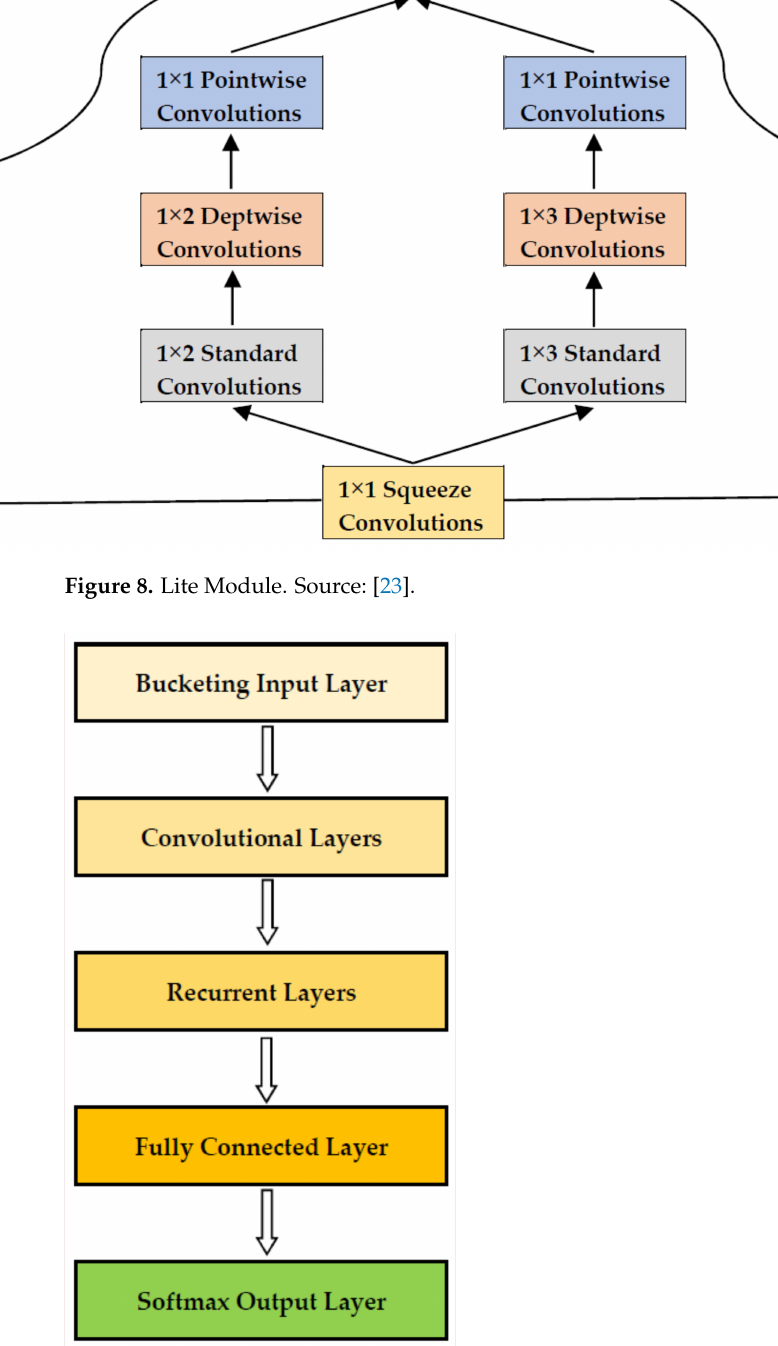
Figure 9. Fused Lightweight Recurrent Neural Network. Source: